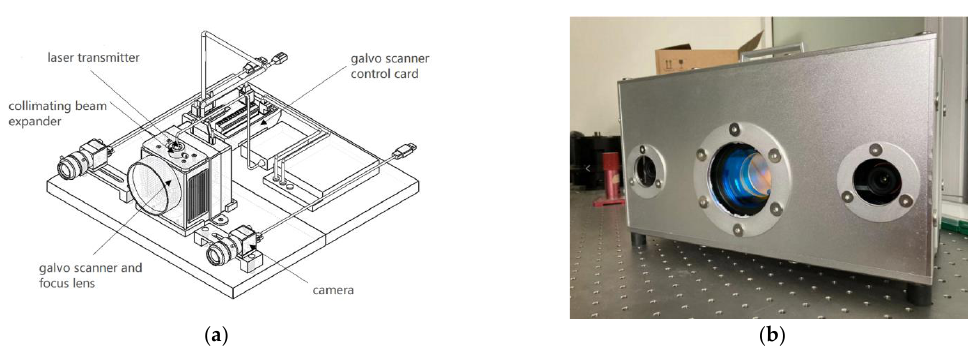
Figure 10. ( a ) System hardware design schematic diagram and ( b ) actual laser 3D projection system.